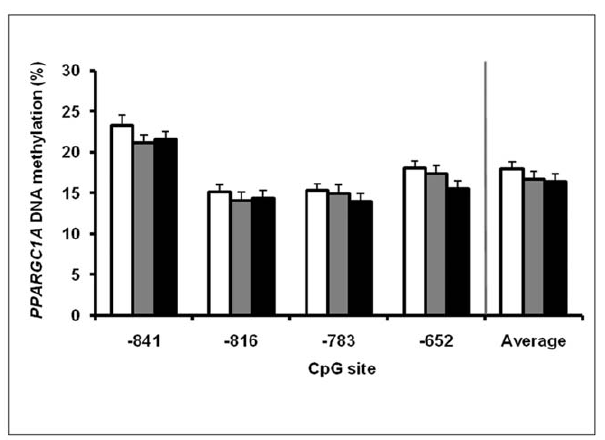
Figure 3. DNA methylation at different CpG sites in the promoter region of PPARGC1A in skeletal muscle. The FDR participants are stratified according to glucose tolerance status: NGT ( white bars ), IFG/IGT ( grey bars ), T2D ( black bars ). Data are mean 6 SE.